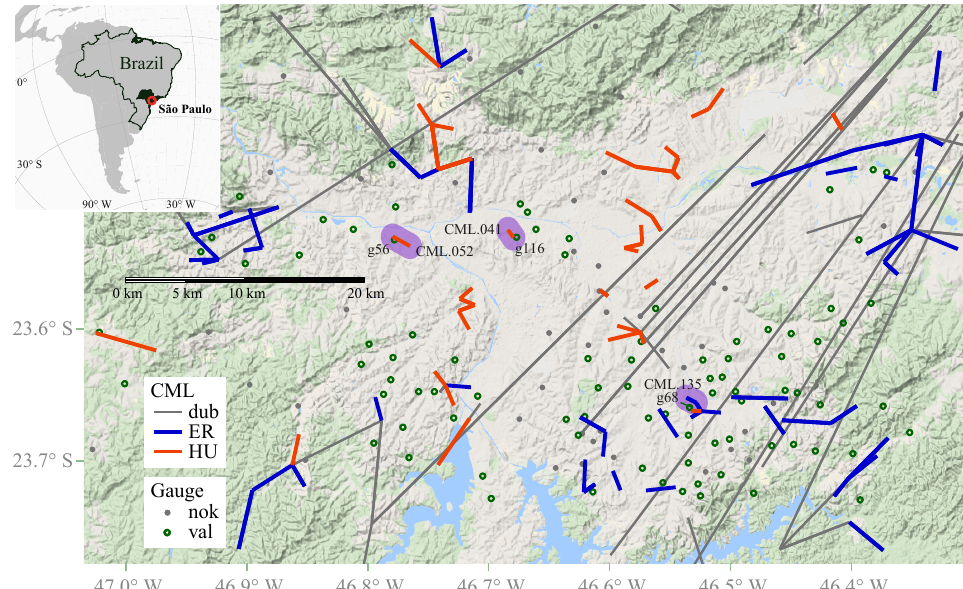
Figure 1. Topology of one CML network in the city of São Paulo, Brazil. 54 Huawei (HU; orange lines) CMLs (40 link paths), and 91 Ericsson (ER; blue lines) CMLs (55 link paths) are shown. The grey link paths (“dub”) are the 68 CMLs (HU and ER) with frequencies below 15GHz and link lengths above 20km. Such CMLs are not analysed here due to their dubious configuration. CMLs with frequencies above 15GHz and link lengths below 20km (blue and orange link paths) represent very likely combinations. The circles are 152 CEMADEN gauges with 10min resolution available for the studied period (20 October 2014 to 9 January 2015). The 96 green circles (“val”) represent the valid gauges. A gauge is deemed valid if its coefficient of correlation ( r 2 ) is larger than 0.6 and its relative bias (rB) is lower than ± 25% for at least one of the two closest gauges to which it is compared (see Sect. 2.2). The dots in grey (“nok”) are the gauges that do not satisfy these thresholds. The three CMLs surrounded by a purplish shadow are those CMLs for which r 2 (cid:62) 0 . 6 and rB (cid:54) ± 25% against their respective closest gauge (see also Fig. 5). CML data was provided by the Planetary Skin Institute/Italia Mobile. We received CML data from a third party. It was not possible to verify the topology of the network shown in Fig. 4 on-site, which we suspect not to be accurate given the orientation of the long links. The geographical location of São Paulo is given in the upper left corner. The DEM was extracted from Google Maps (Google Maps,